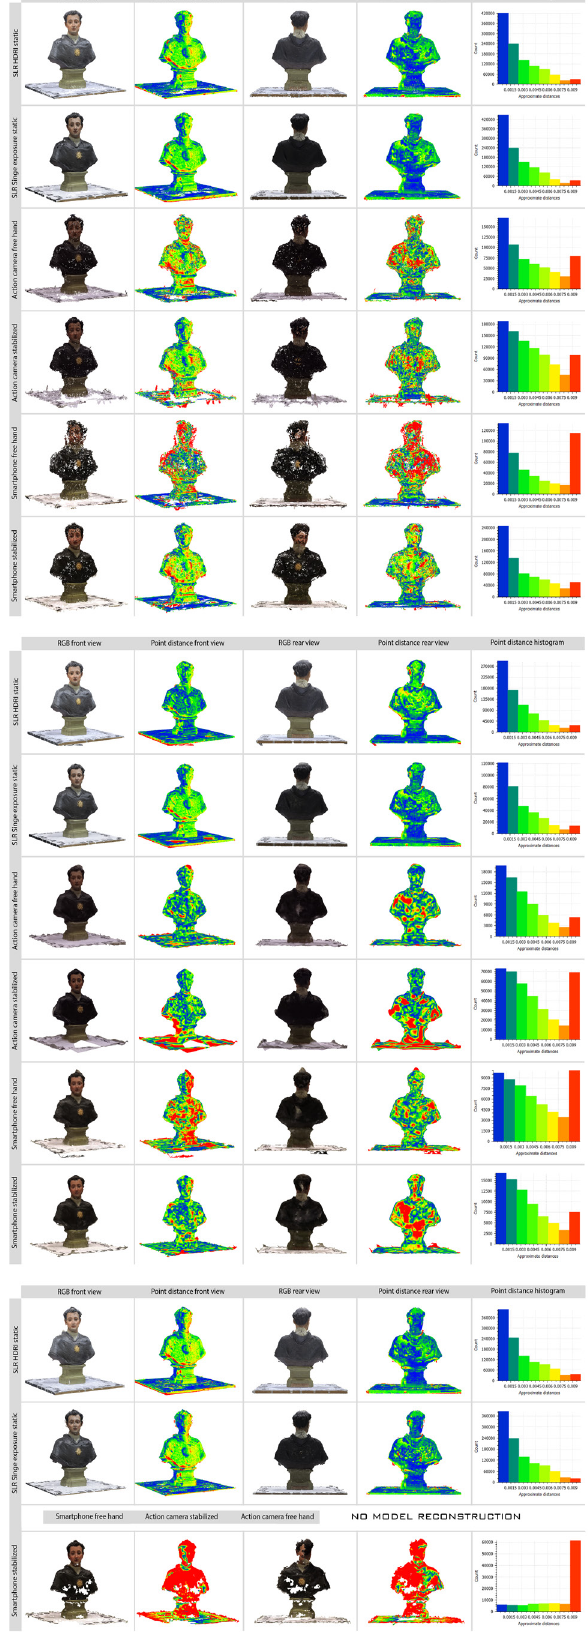
Figure 13. Mesh comparison between photogrammetric model and 3D laser scanning reference (processed by Agisoft Metashape, 3DFlow Zephyr and Pix4D Mapper